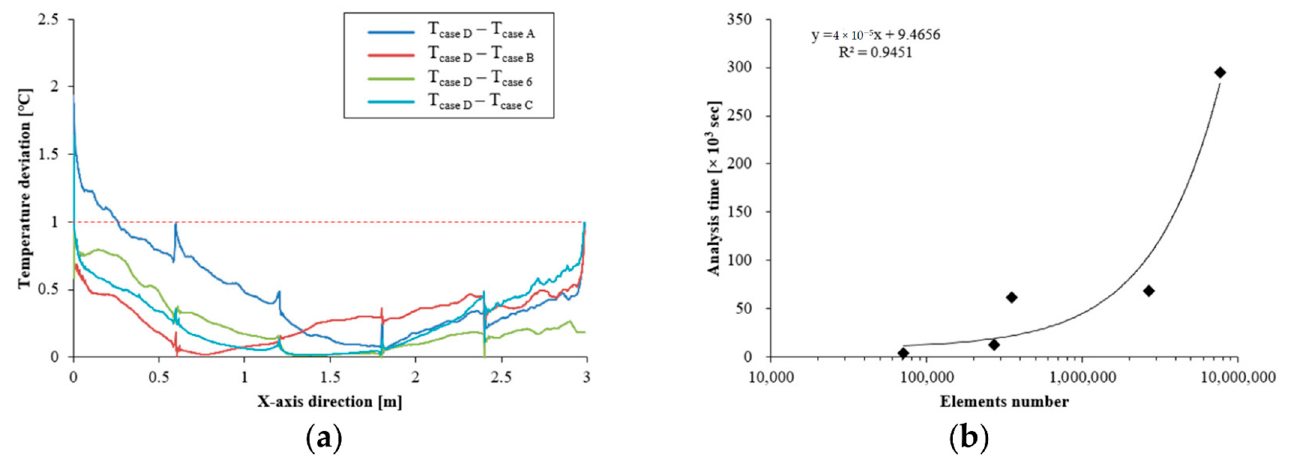
Figure 5. Methods for selecting the suitable grid model: ( a ) temperature deviations of other grid models with respect to Case D as the good quality grid model; ( b ) analysis time according to the number of grids. 4 × 10 − 5